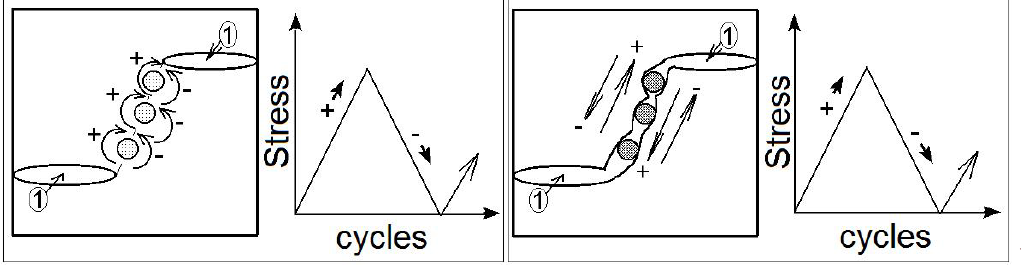
Figure 5: Schema of cascade events in fatigued metals during sequentially, first, cylindrical, then, ellipsoidal, and, at last, spherical particles formation because of shear and volume rotation in crosspieces between mesotunnels “1”. So, the spherical particles formation process performs because of the mesotunneling effect, the rotation instability into crosspieces between tunnels, and free surfaces formation by the rotated volumes with cylindrically-shaped particles. Then, these particles crush, roll, and ellipsoidal-spherical particles form into crosspieces under mode III opening of mode I fatigue cracks